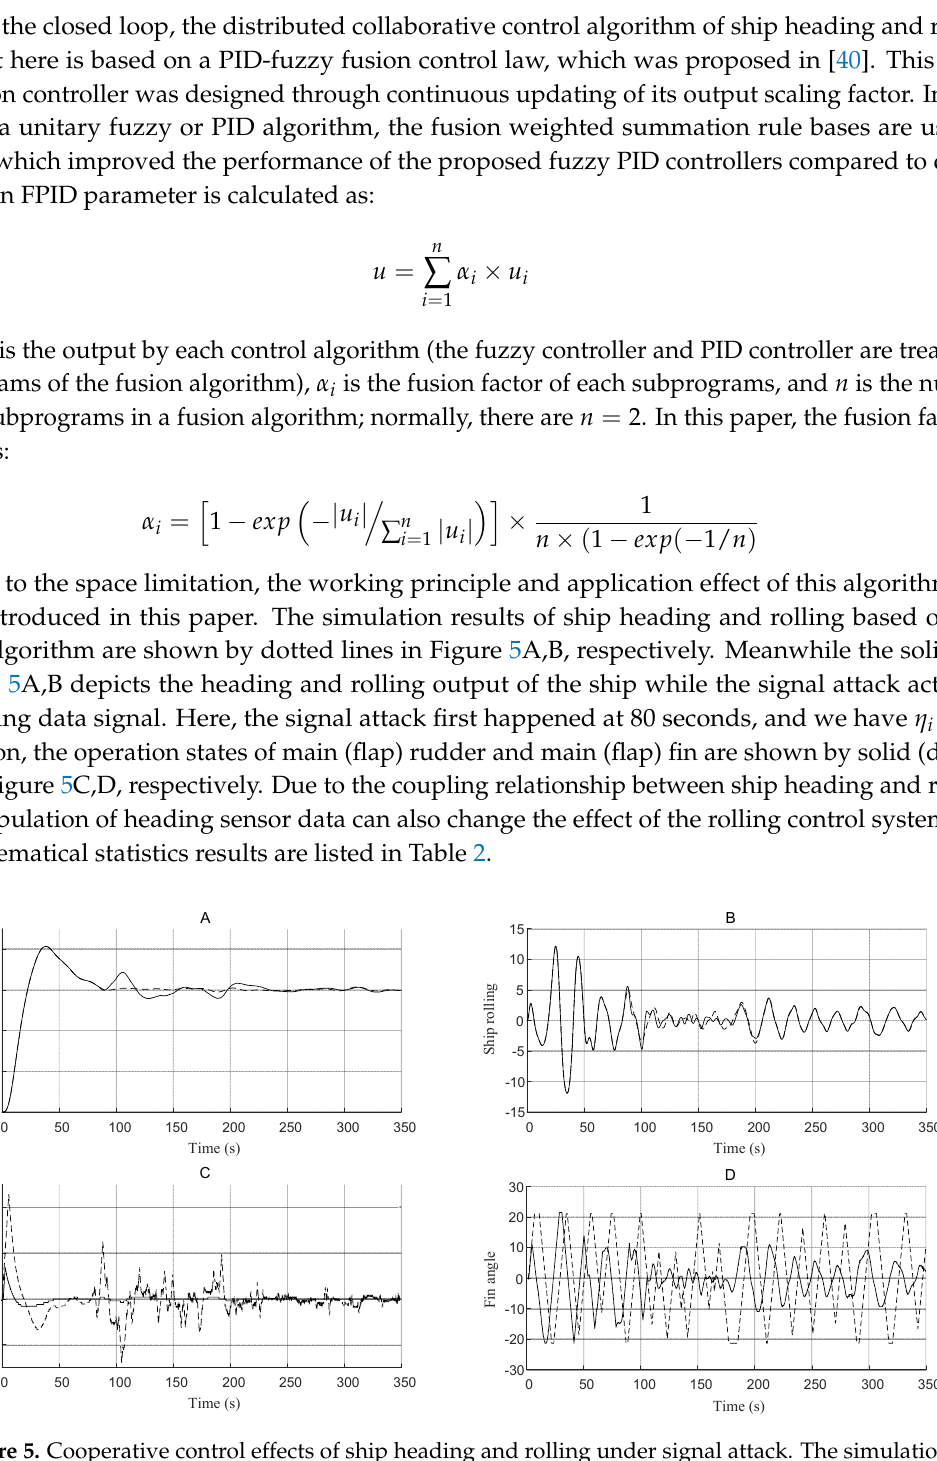
Figure 5. Cooperative control effects of ship heading and rolling under signal attack. The simulation results of ship heading and rolling based on this control algorithm are shown by dotted lines in Figure A,B, respectively. Meanwhile the solid line in ( A , B ) depicts the heading and rolling output of the ship while the signal attack acted on the heading data signal. Here, the signal attack first happened at 80 s, and we have hi = 0.5. In addition, the operation states of main (flap) rudder and main (flap) fin are shown by solid (dotted) lines in ( C , D ),